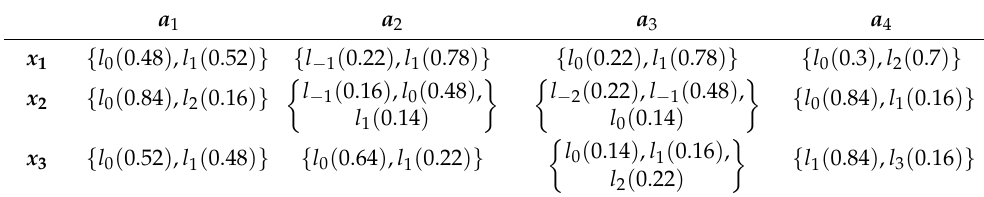
Table 3. Aggregate DMs’ decision evaluation.